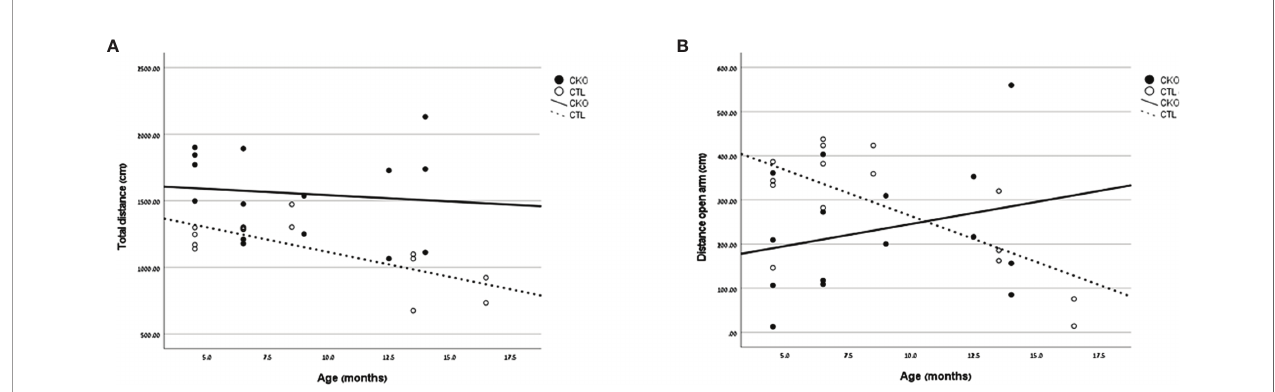
FIGURE 2 | Results of the elevated Plus Maze. Graphs showing, for each of the groups (CKO and CTL), correlations between the animal age and (A) total distance covered (cm) or (B) distance covered in the open arms